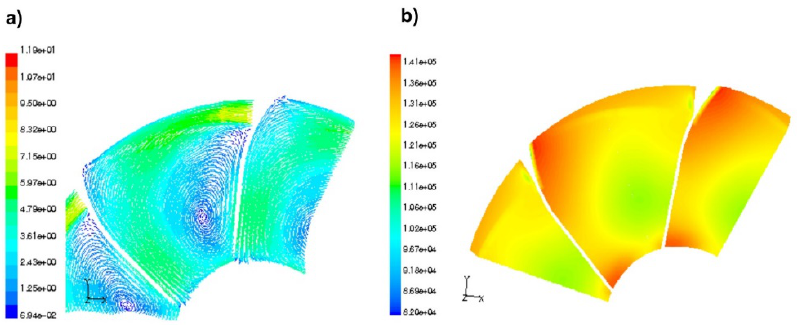
for ε k = 25 ◦ Figure 24. The field of: ( a ) velocity [m/s]; ( b ) static pressure [Pa] in the channels of the guide vanes for ε k = 25°.